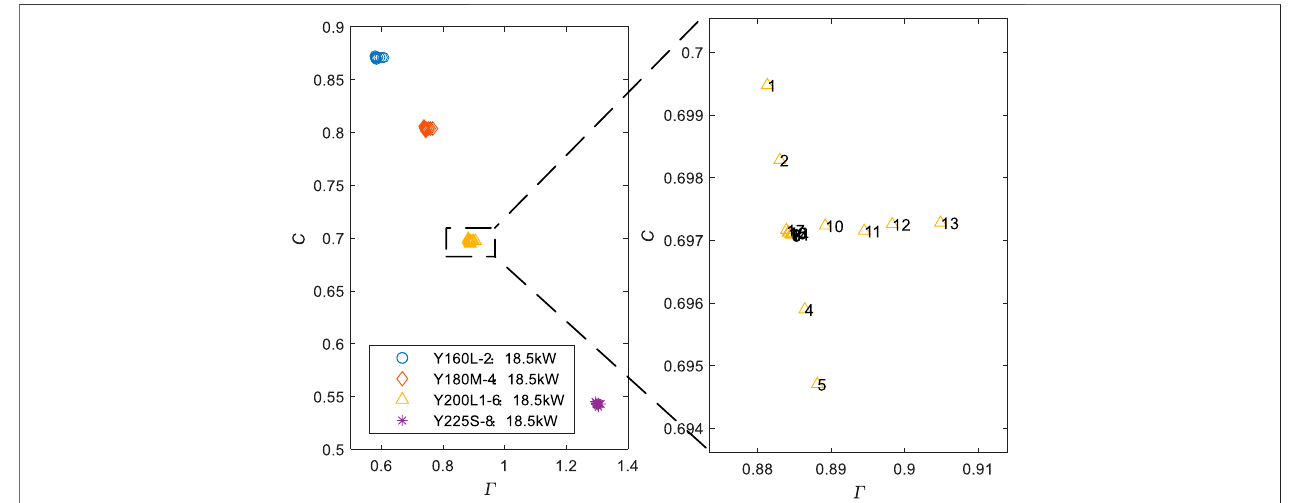
Frontiers in Energy Research |